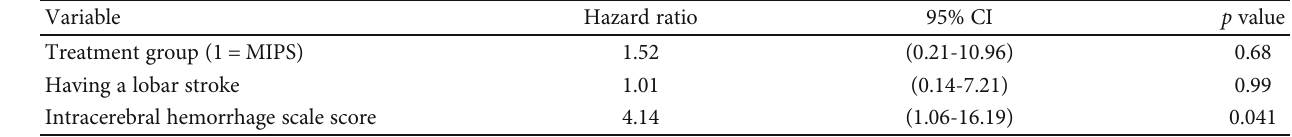
Table 3: The Cox proportional hazard model for inpatient death.